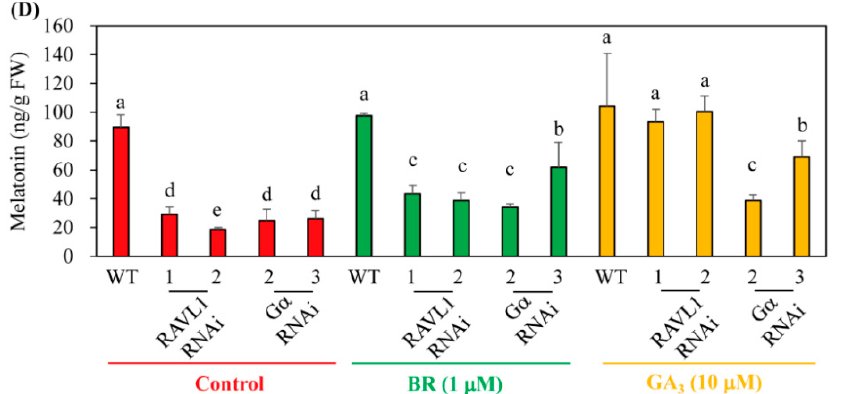
Figure 8. Effects of exogenous BR and GA in RAVL1 and G α RNAi transgenic rice seedlings. ( A–C ) Phenotypes of 7-day-old rice seedlings after cadmium treatment in response to exogenous BR and GA 3 treatments. ( D ) Melatonin levels of control-, BR-, and GA-treated rice seedlings. Seven-day-old wild-type (WT) and RNAi rice seedlings were challenged with either BR or GA for 24 h. The resulting rice seedlings were treated with 0.5 mM cadmium for 3 days under conditions of continuous light at 28 °C followed by HPLC quantification of melatonin. Different letters denote significant differences ( p < 0.05), as determined by Tukey’s HSD post hoc tests. Mock, water containing 0.1% ethanol; BR, 1 μ M epibrassinolide; GA 3 , 10 μ M gibberellic acid 3.